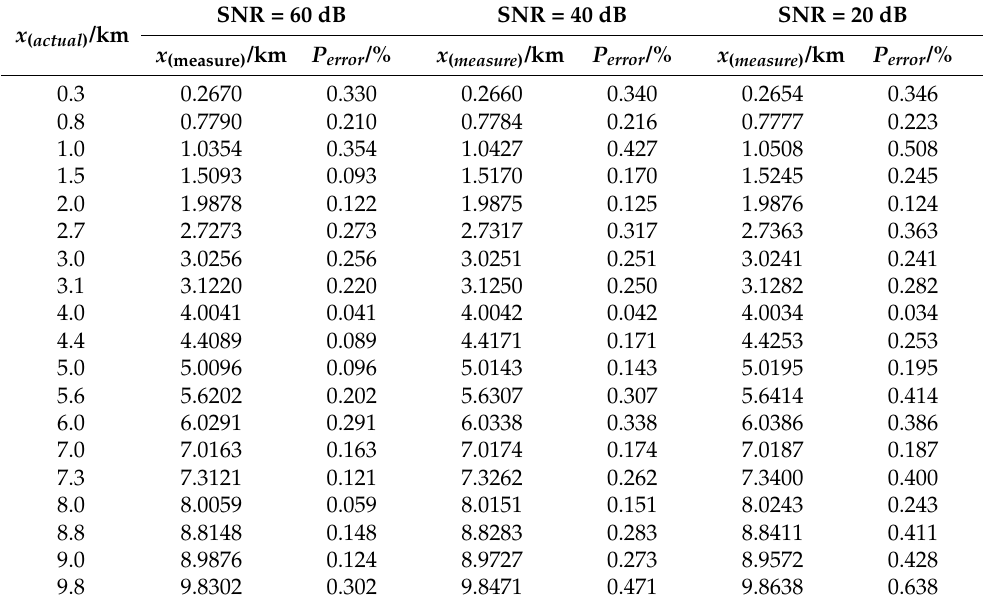
Table A2. Fault location results and errors with white noise.